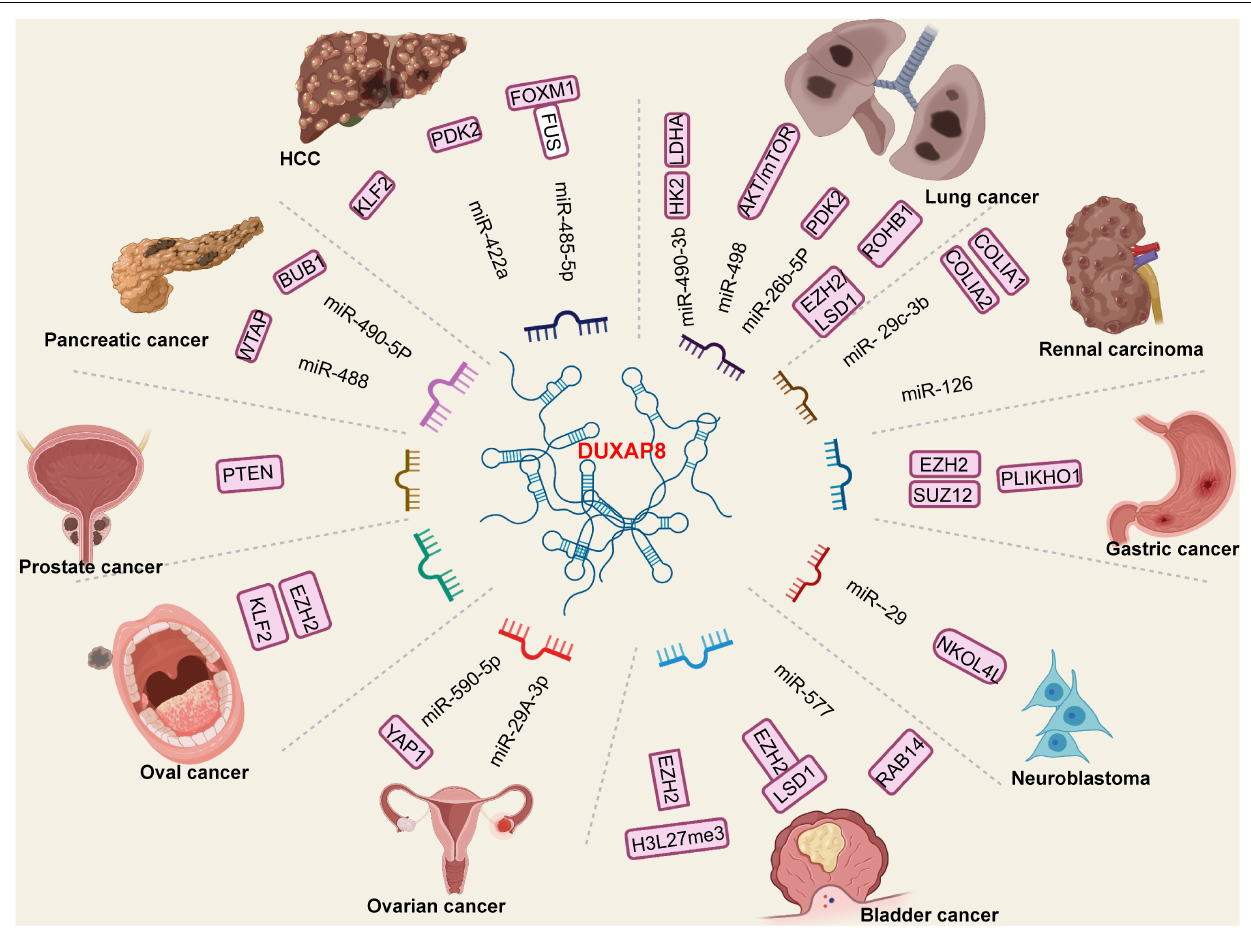
FIGURE 3 | The specific long non-coding RNA (lncRNA)-miRNA oncogene regulation mechanism of DUXAP8 in various cancers. The DUXAP8 was significantly overexpressed in tumor tissues. The increased DUXAP8 function as an oncogene and a sponge which targeting mi-RNAs and activated downstream oncogene